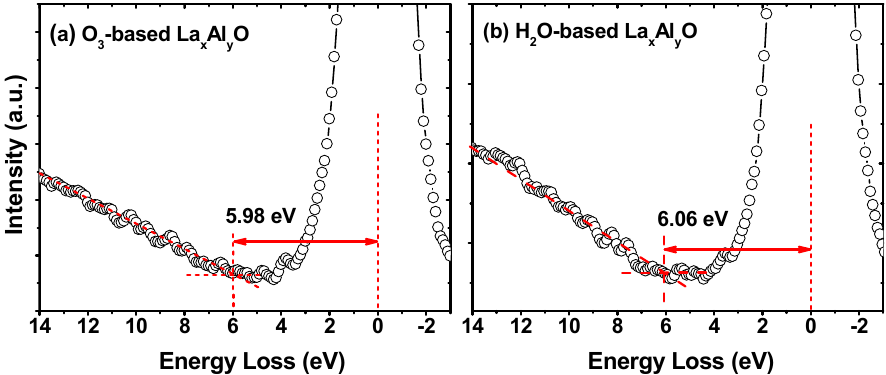
Figure 4. O 1 s energy-loss spectra for the 10 nm ( a ) O 3 -based and ( b ) H 2 O-based La x Al y O films. Results of the calculated band gaps and band offsets are shown in the schematic diagram in Figure 5. It is worth noting that the band gap values of the deposited La x Al y O films are smaller than